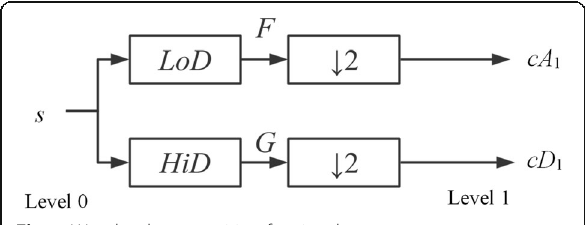
Fig. 5 Wavelet decomposition for signal s